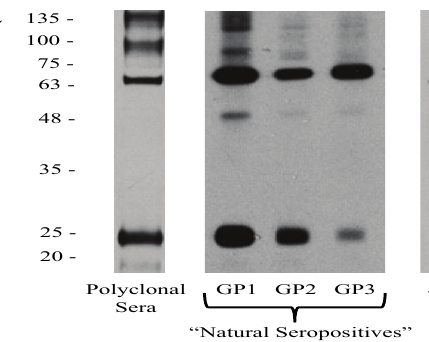
Figure 1. Western blot analysis of sera from three “naturally seropositive” commercially purchased outbred Hartley guinea pigs. ( a ) Western analysis using a pooled, high-titer polyclonal anti-GPCMV antisera from guinea pigs immunized with adjuvanted viral particles [30] or sera from three “natural seropositive” guinea pigs (GP1, GP2, GP3) obtained from a commercial supplier, using sucrose gradient-purified virions from 22122 strain as target antigen. Two independently derived, monospecific anti-GPCMV gB antibodies (moab 29-29 [31] (gB1) and moab IE321 (gB2)) are included as controls. ) CIDMTR virus (right panel) to ( b ) Photomicrographs comparing CPE of low-passage (P 2 GPCMV strain 22122 (left panel) following infection of GPL cells. CIDMTR plaques are more rounded, with elliptical appearance, compared to the more spindle-like morphology of 22122-infected fibroblasts. Plaques photographed at 60×